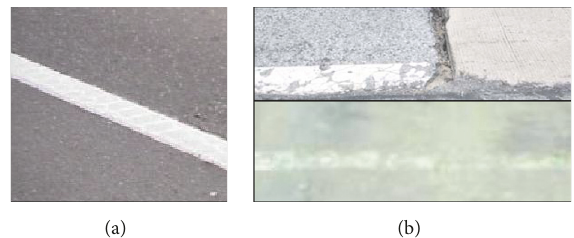
Figure 3: Example of white line road markings in Thailand . (a) is the marking in good condition whereas (b) is damaged markings (images from [7,